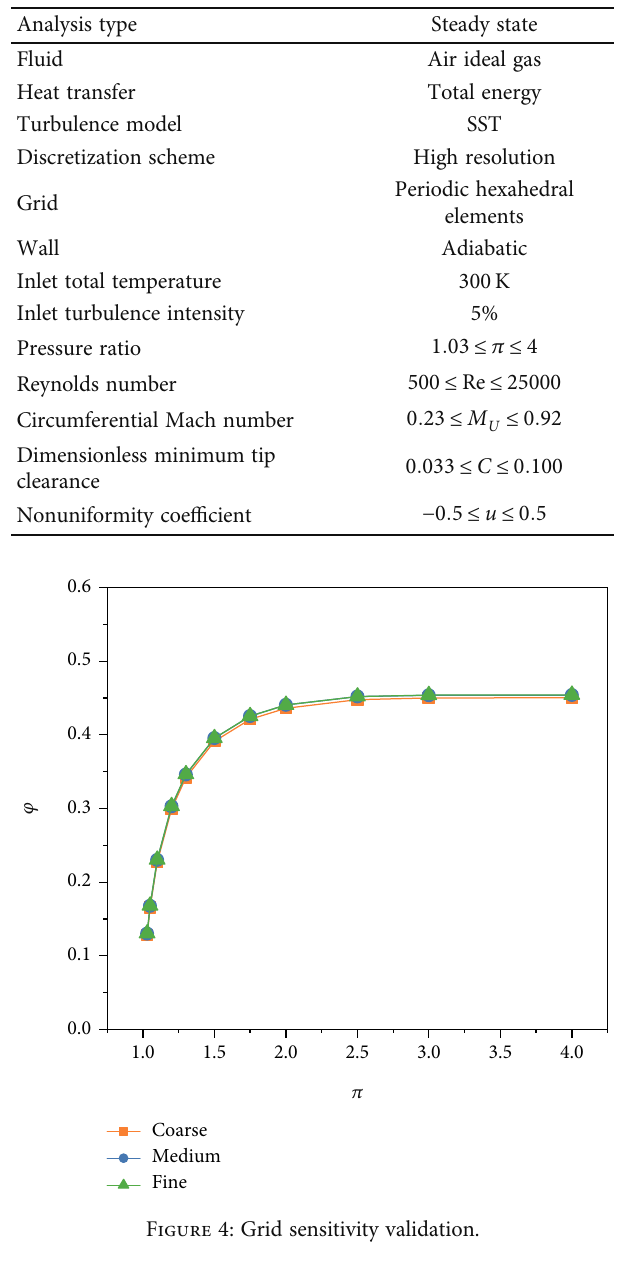
Figure 3: Mesh. Table 2: Numerical method and boundary conditions.